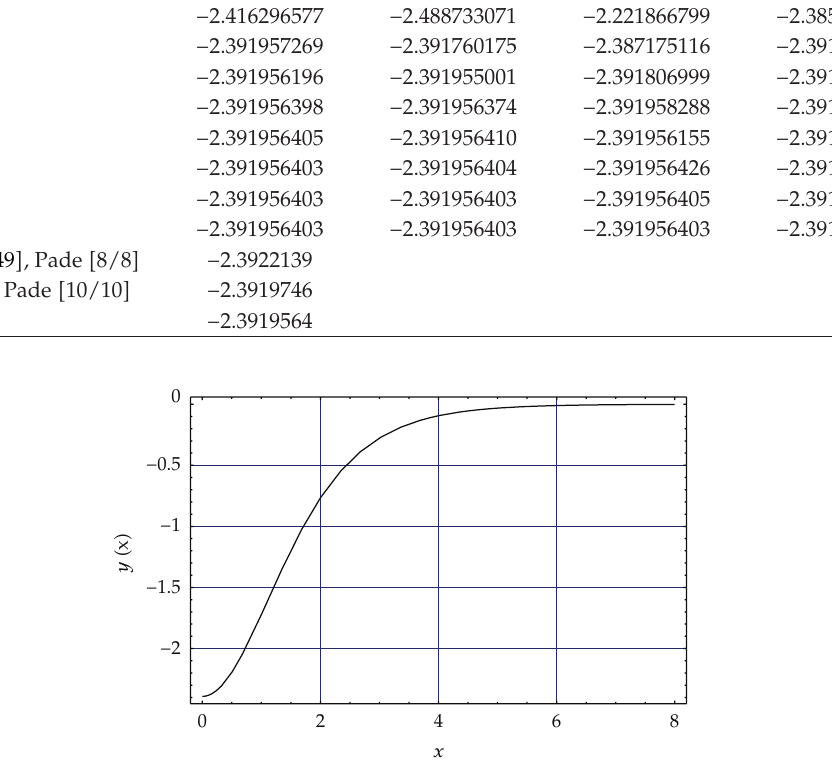
Figure 2: Computational results of y (cid:4) x (cid:3) for Example 4.5 using the CGR scheme for φ a , K (cid:9) 1 / 2, L (cid:9) 2, and N (cid:9)